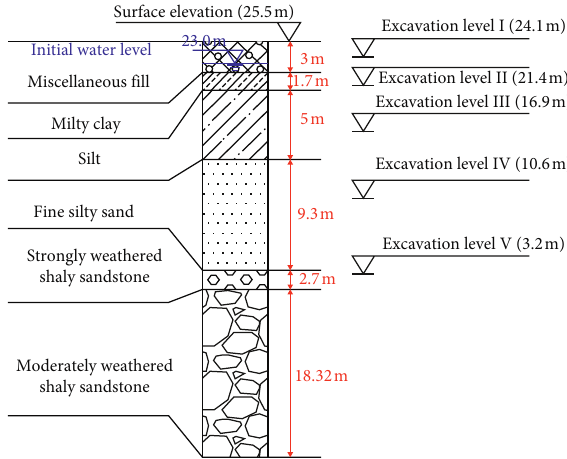
Excavation level I (24.1m)